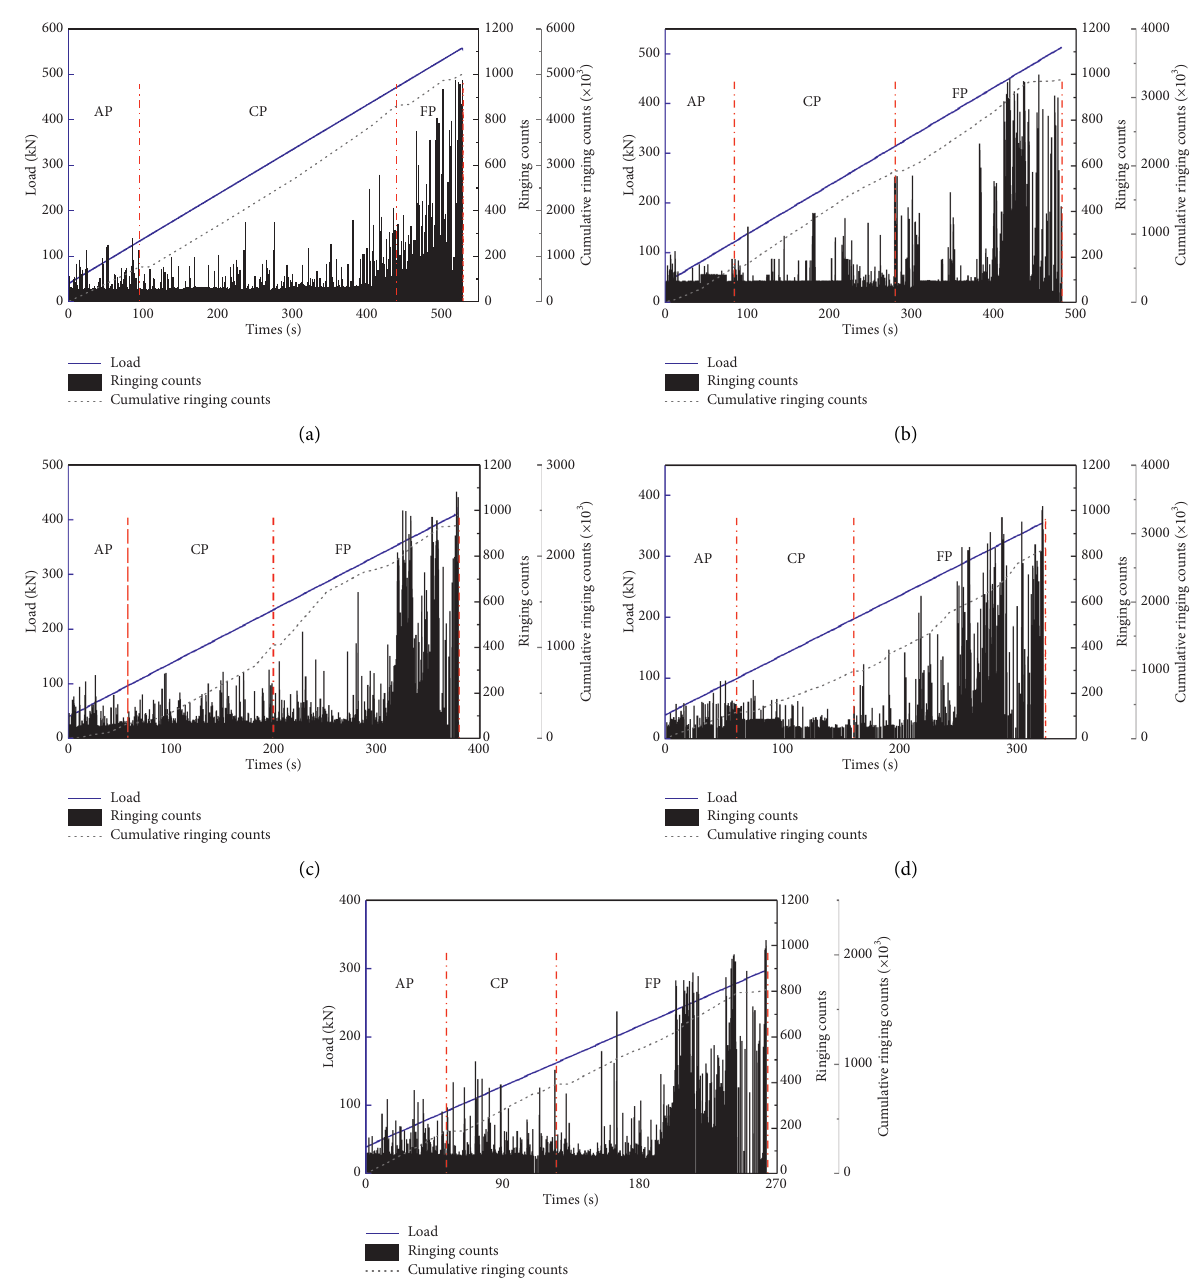
Figure 5: Relationship between load and time and ringing counts measured in granite samples that had undergone different numbers of freeze-thaw cycles under triaxial compression. (a) 0 freeze-thaw cycles, (b) 10 freeze-thaw cycles, (c) 30 freeze-thaw cycles, (d) 60 freeze- thaw cycles, and (e) 90 freeze-thaw